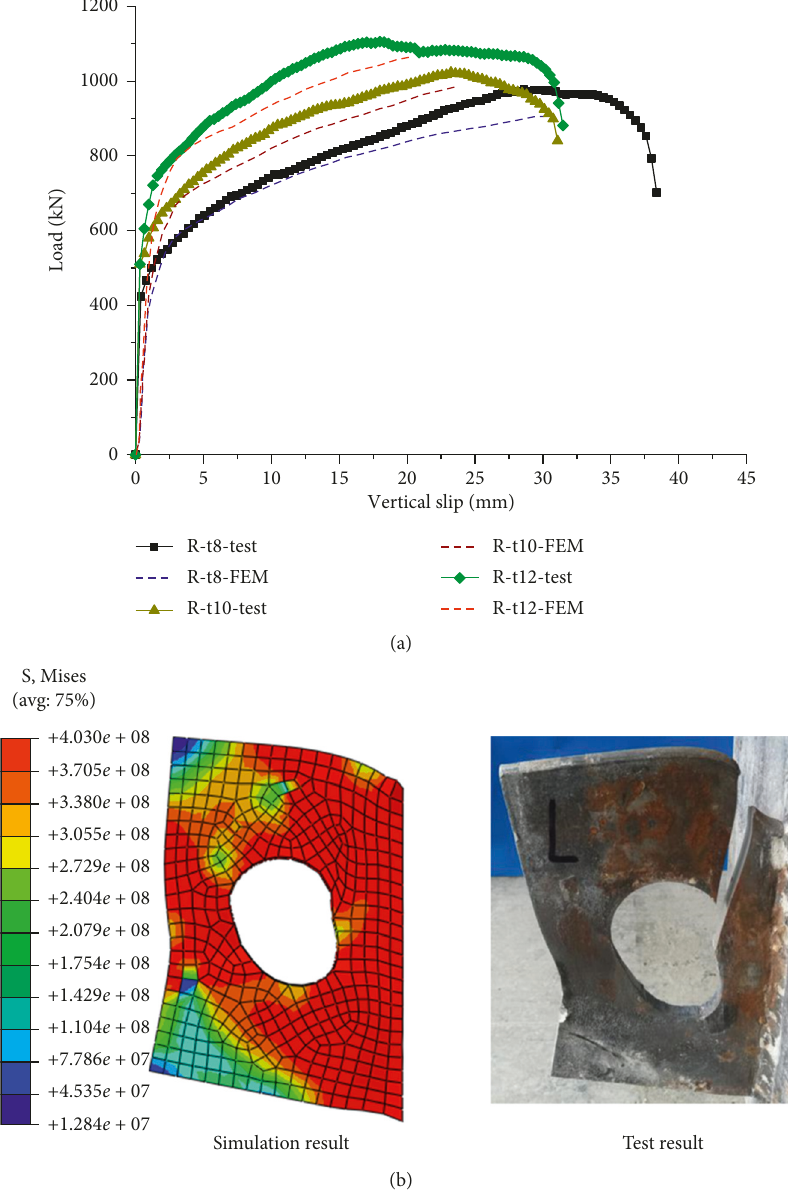
Figure 10: Validation of the FE models: (a) load-slip curves; (b) failure modes of the perforated steel plate (group R-t10